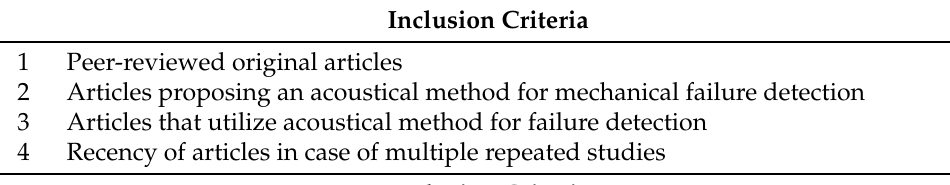
Table 3. Inclusion and exclusion criteria.